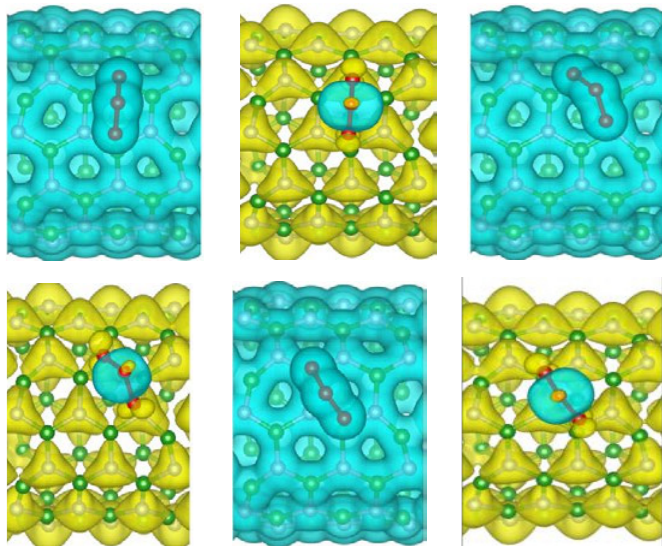
Figure 8. Calculated Kohn-Sham and Hartree-Fock potential Isosurfaces for O 3 adsorbed BN nanotubes.